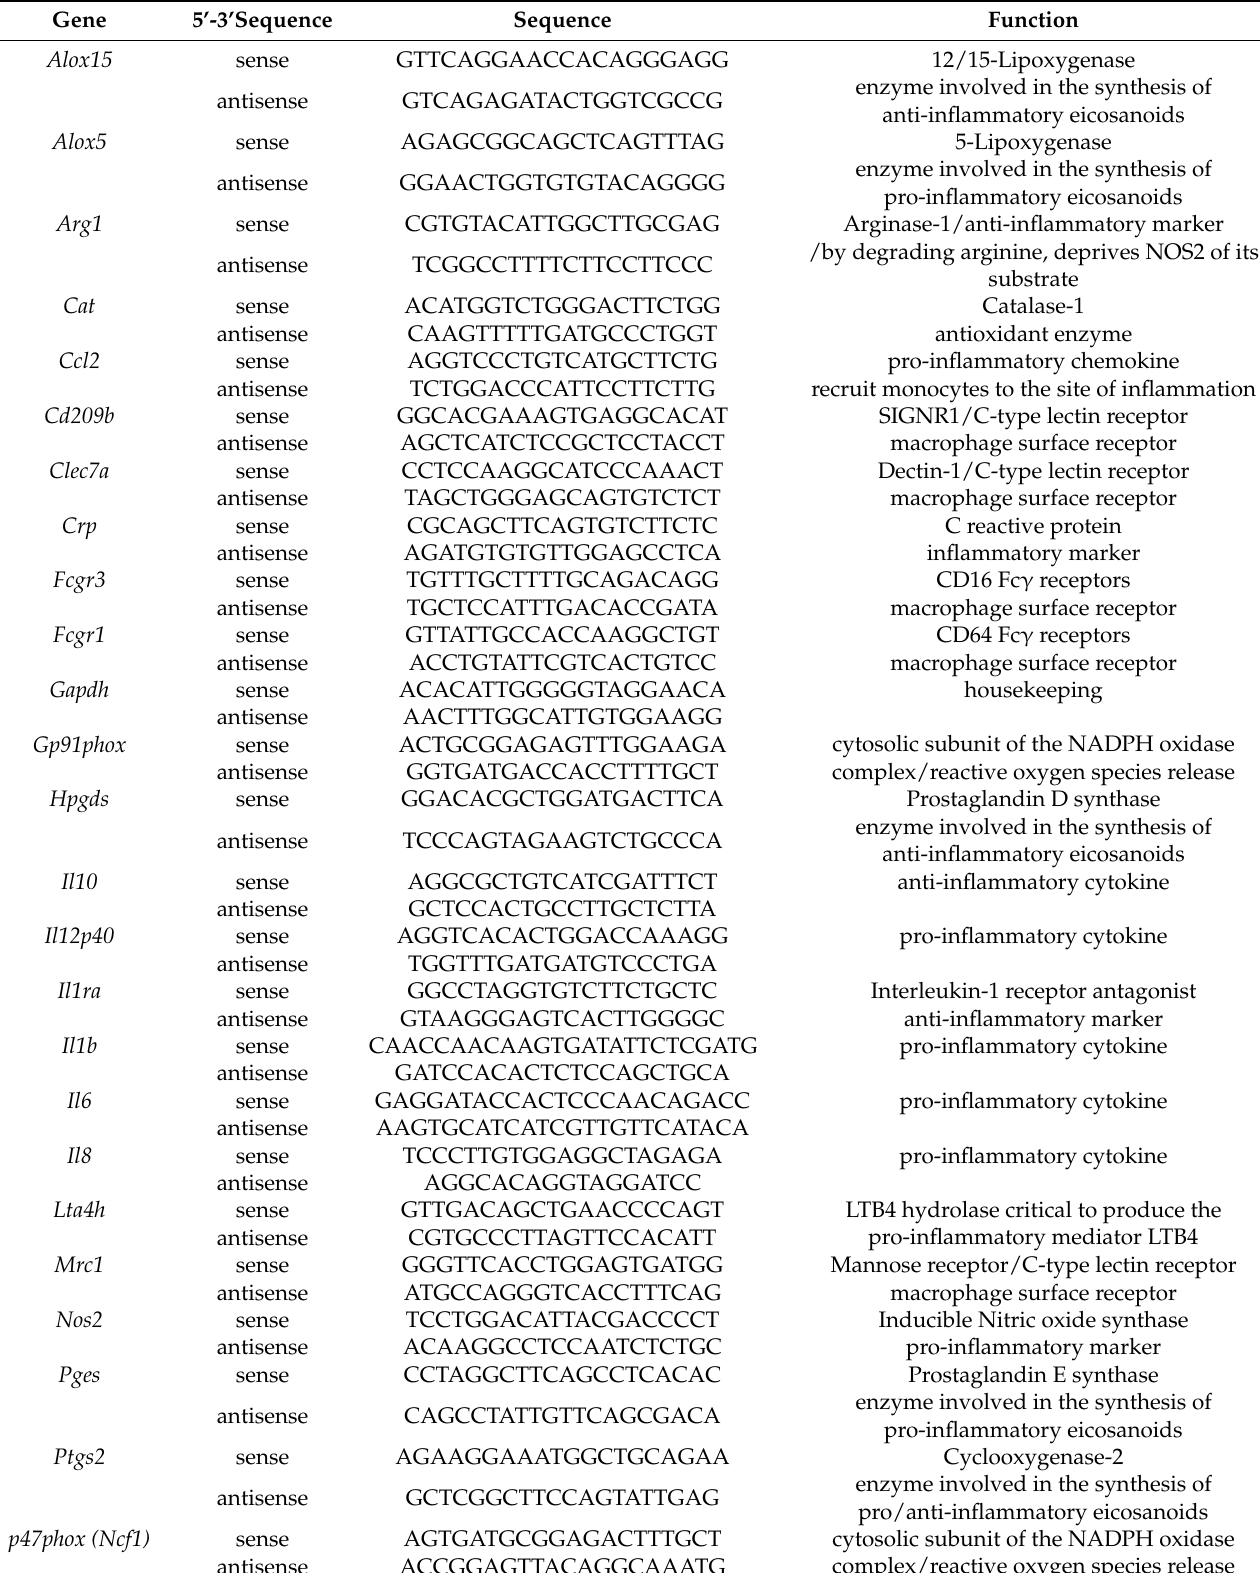
Table 2. Primer sequences used in